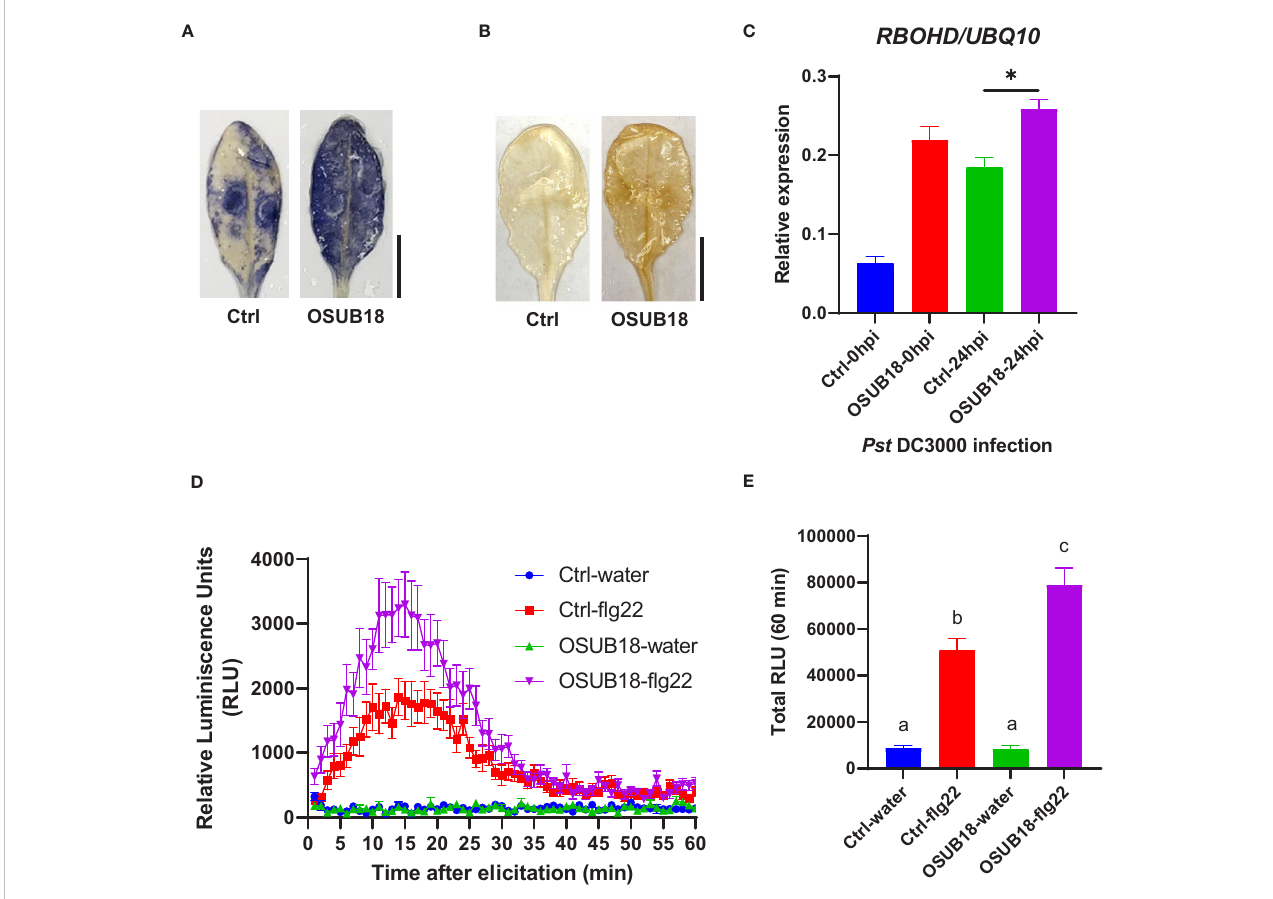
FIGURE 6 OSUB18 root drench treatment triggered strong ISR in A thaliana against the bacterial pathogen Pst DC3000 via signi fi cantly stronger ROS production and higher RBOHD gene expression. (A) Col-0 plants drenched with OSUB18 produced more intense superoxide anion upon the Pst DC3000 infection (24hpi), as illustrated by the nitroblue tetrazolium (NBT) staining assay. Scale bar = 10 mm. (B) Col-0 plants drenched with OSUB18 produced more intense hydrogen peroxide upon the Pst DC3000 infection (24hpi), as illustrated by the 3,3-diaminobenzidine (DAB) staining assay. Scale bar = 10 mm. (C) Relative gene expression of the ROS-responsive gene RBOHD . Water or OSUB18-drenched plants were infected with Pst DC3000 by syringe injection. 0 or 24 hours later, the injected leaves were collected for the qRT-PCR assay. The UBQ10 gene was used as an internal reference in the qRT-PCR assay. (D) Col-0 plants pre- drenched with OSUB18 showed a more vigorous ROS burst elicited by the bacterial PAMP fl g22. (E) Quanti fi cation of the ROS burst in (D) . Data present mean ± SE of three biological replicates. Data with different letters or * indicate a p- value < 0.05 on Student ’ s t-test or